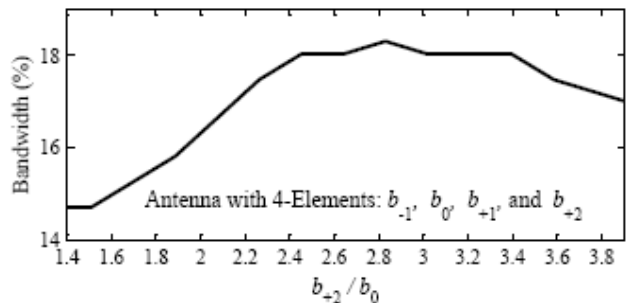
Figure 4: Variation of the bandwidth of a 4-element CCLA with b +2